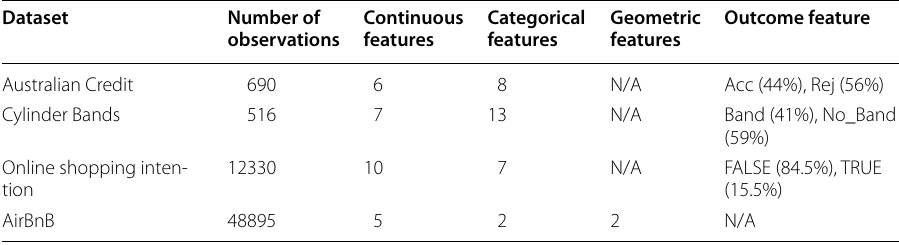
Table 1 Overview of